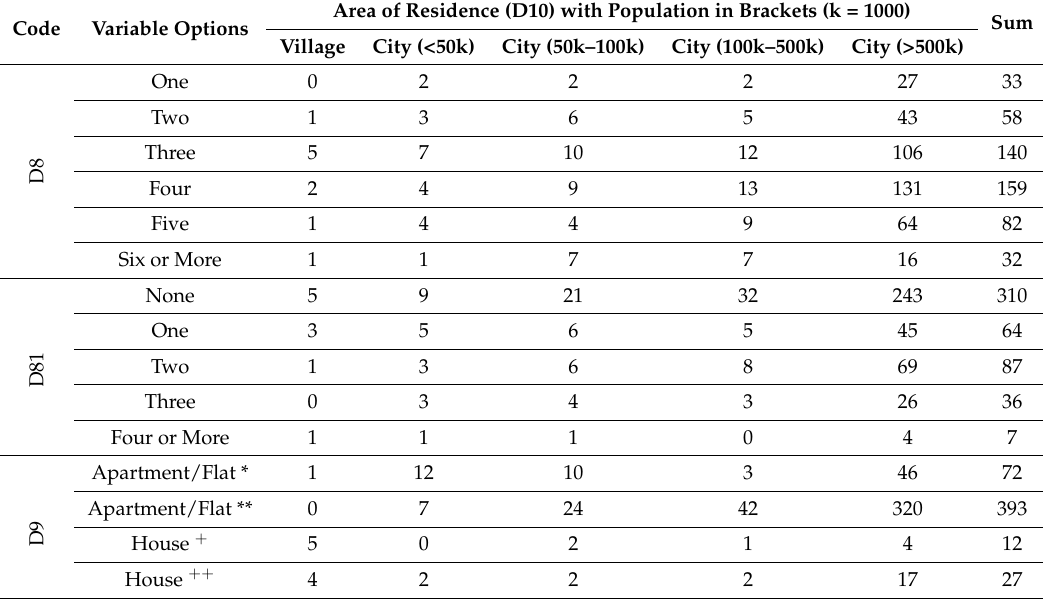
Table 4. Cross tabulation of Age in Year (D2) with Gender (D1), Relationship Status (D3), Educational Level (D4) and Employment Status